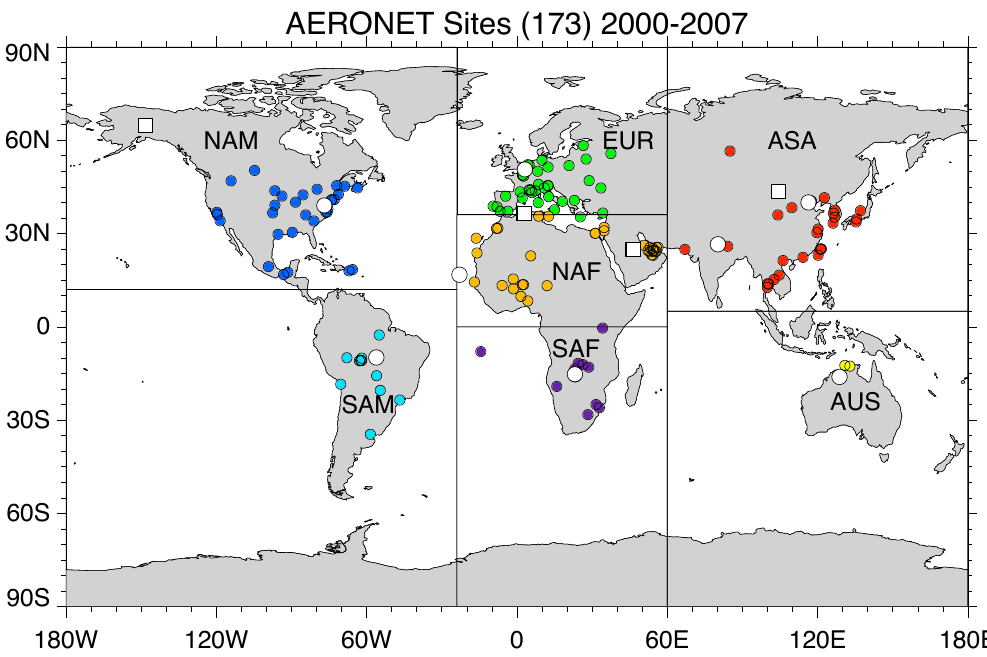
Fig. 4. AERONET site locations where simultaneous τ and τ a data are available for at least 20 days during 2000 to 2007 (total 173 sites). Eight sites in white circles are selected for detailed analysis shown in Fig. 5 (GSFC, USA, 40.0 ◦ N, 76.8 ◦ W; Lille, France, 51.6 ◦ N, 3.1 ◦ E; Kanpur, India, 26.5 ◦ N, 80.2 ◦ E; Beijing, China, 40.0 ◦ N, 116.4 ◦ E; Cape Verde, Sal Island, 16.7 ◦ N, 22.9 ◦ W; Alta Floresta,